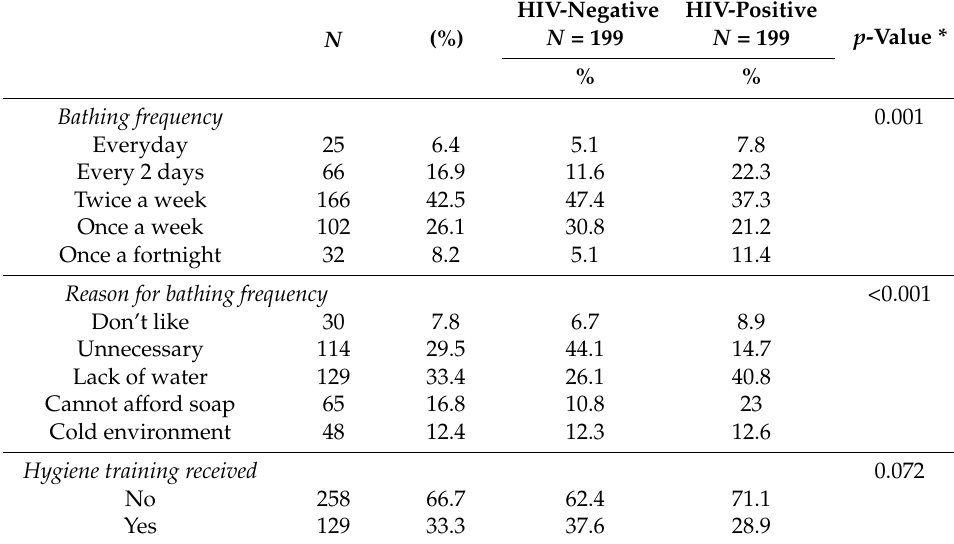
Table 6. A comparison of hygiene indicators among the HIV-negative and HIV-positive groups in Wukro ( N = 398).